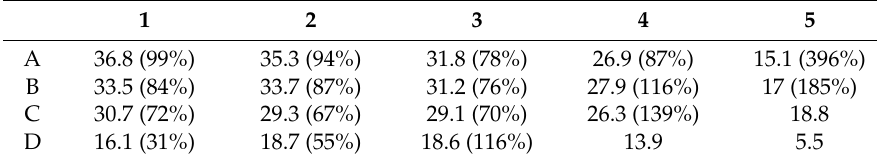
Table 4. SNR (dB) for SAM on step heating thermal data.